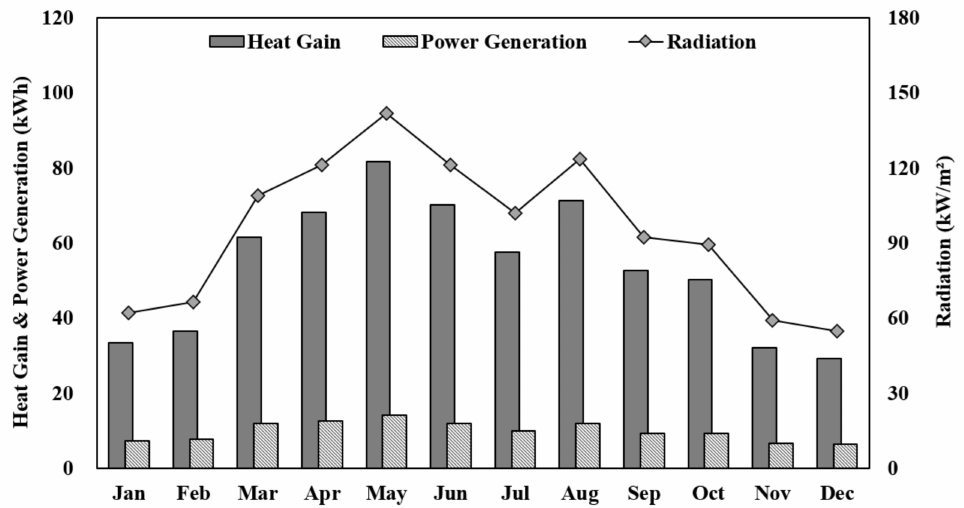
Figure 13. Monthly heat gain and power generation of the PVT